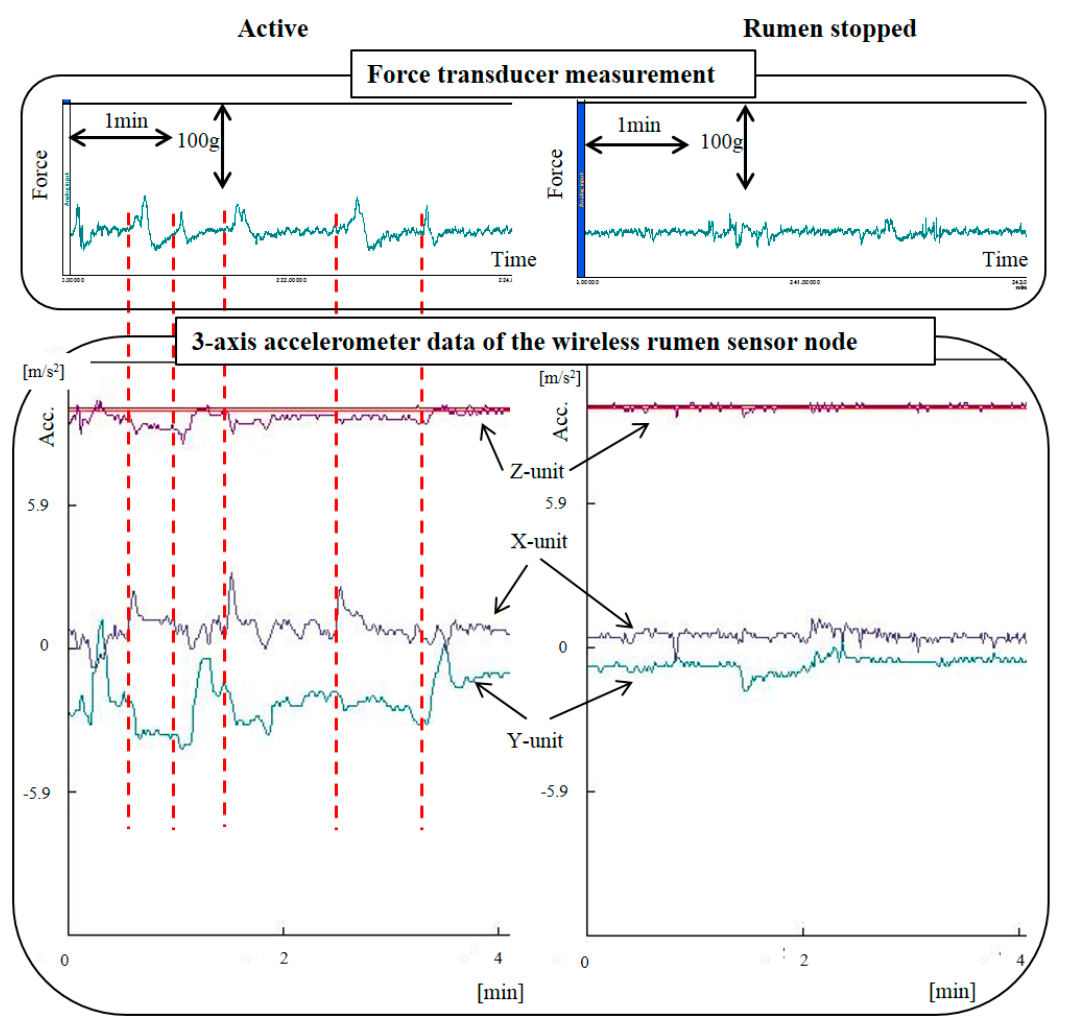
Figure 5. The top part shows the result of the force transducer measurement, while the bottom part shows the result of the three-axis accelerometer data of the wireless sensor